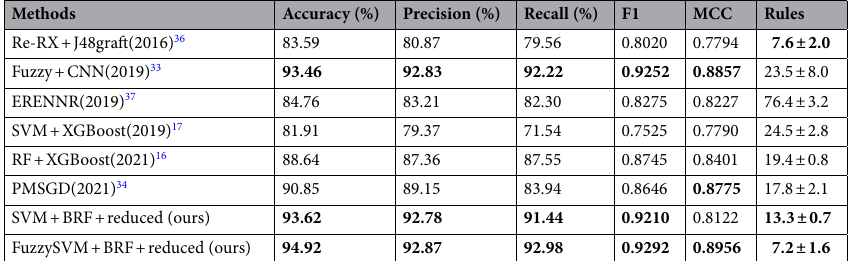
Table 8. Average results of fivefold CV for extracted rule sets on CHNS dataset. Significant values are in bold.